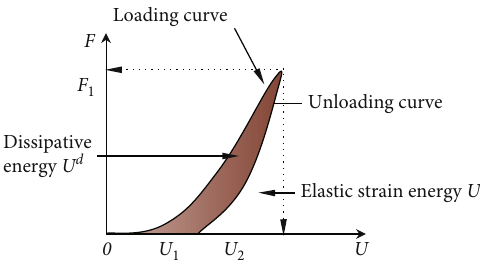
Figure 9: Deformation produced by friction at the specimen top and bottom faces.